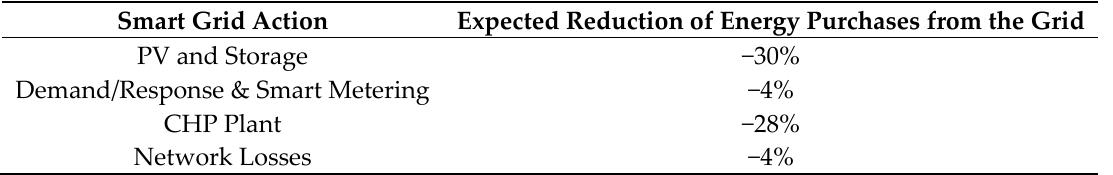
Table 4. Project effects on the energy purchases.